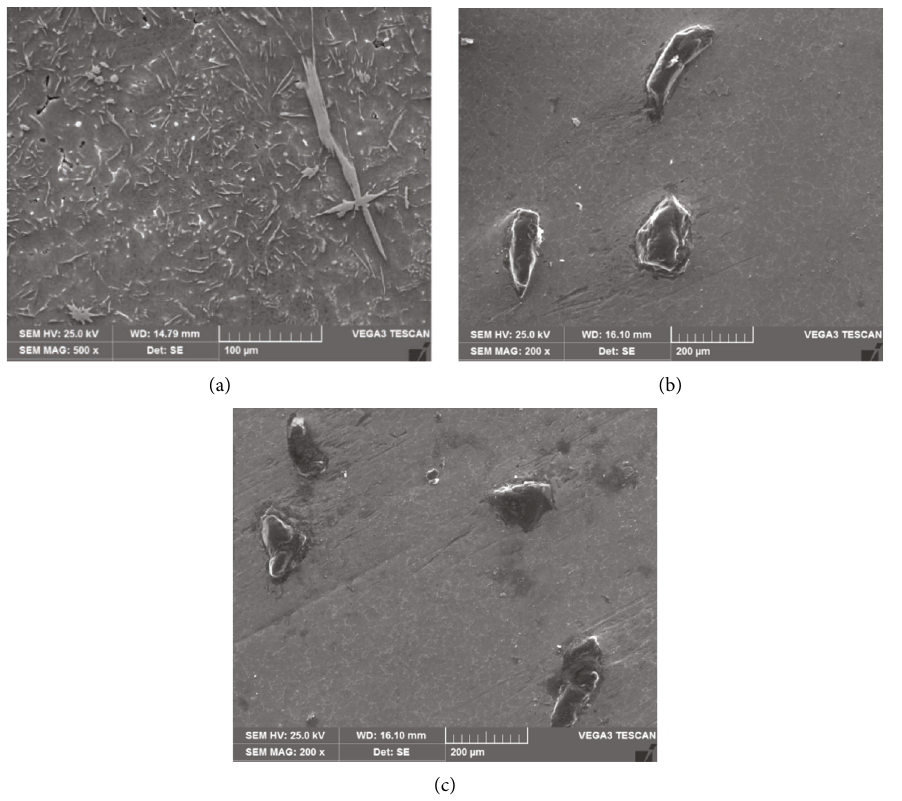
Figure 4: SEM images of (a) as-cast Al7075, (b) Al7075-3wt% TiC, and (c) Al7075-6 wt.% TiC composites.